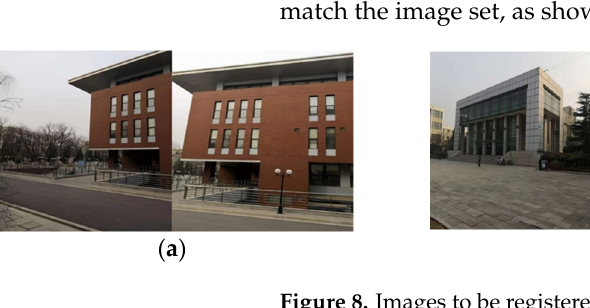
( d ) Figure 9. Comparison of feature points extraction and matching results: ( a ) this article; ( b ) BRISK + improved GMS; ( c ) BRISK + RANSAC; ( d ) ORB + RANSAC.